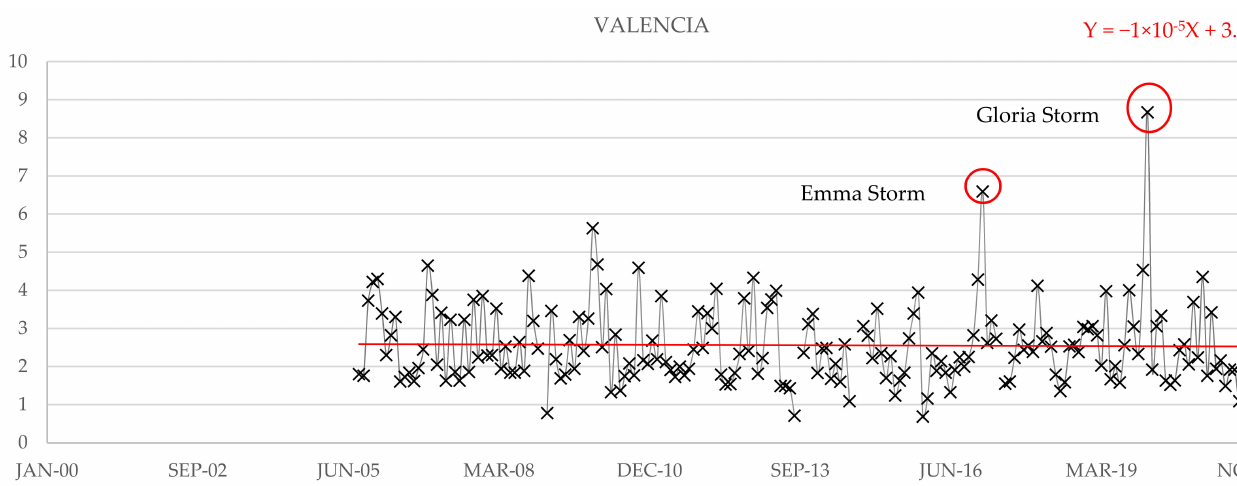
Figure 7. Evolution of Hs maxima in